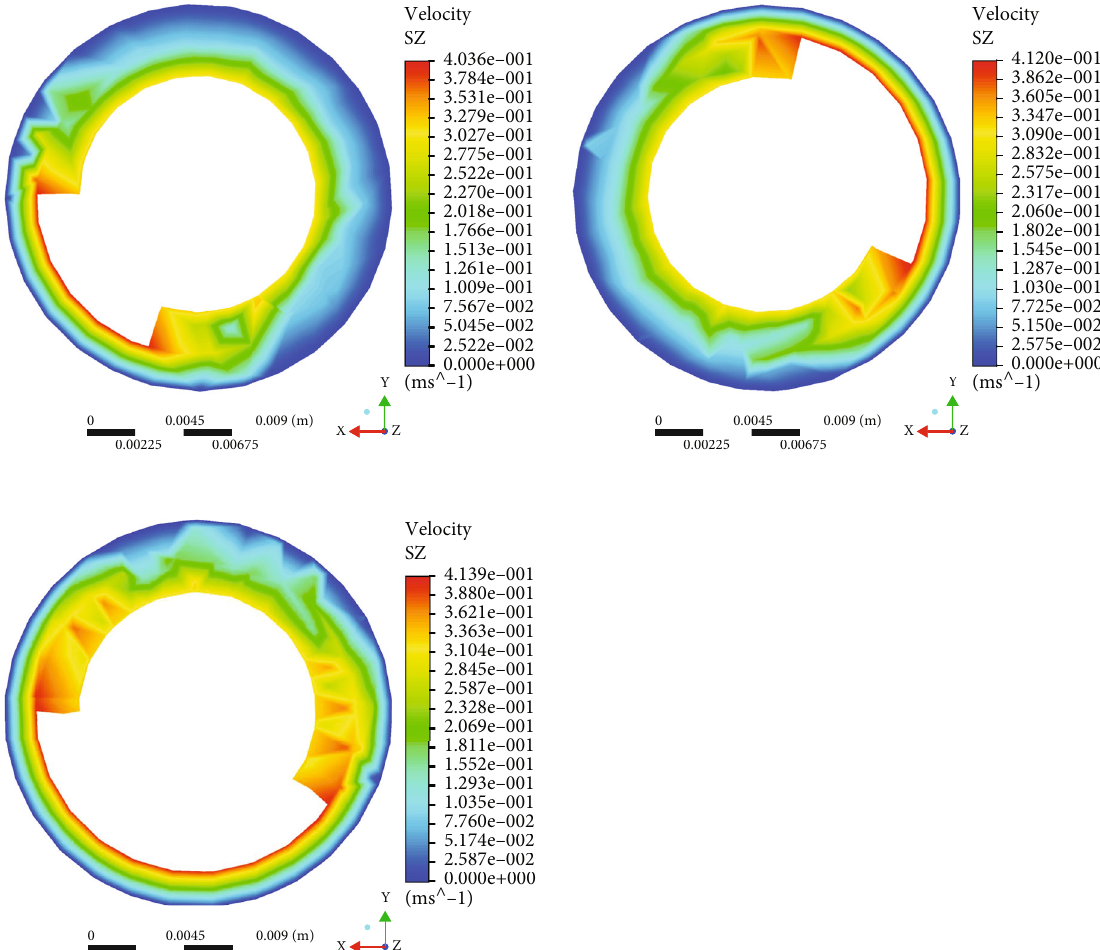
Figure 5: Simulation of intermediate plane velocity pro fi le of capsule robot at the same rotational